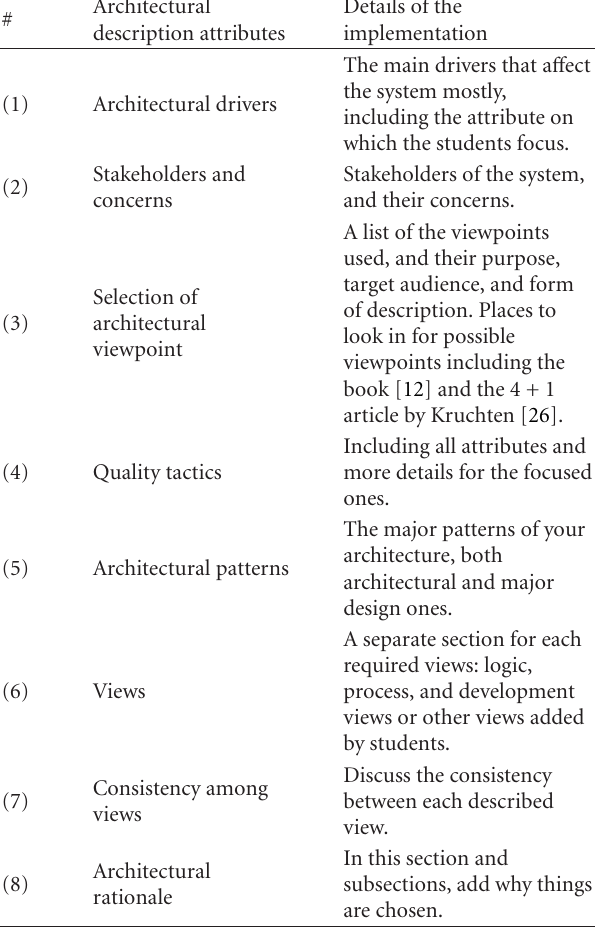
Table 5: Attributes of quality requirements. A1: The role in game should not get